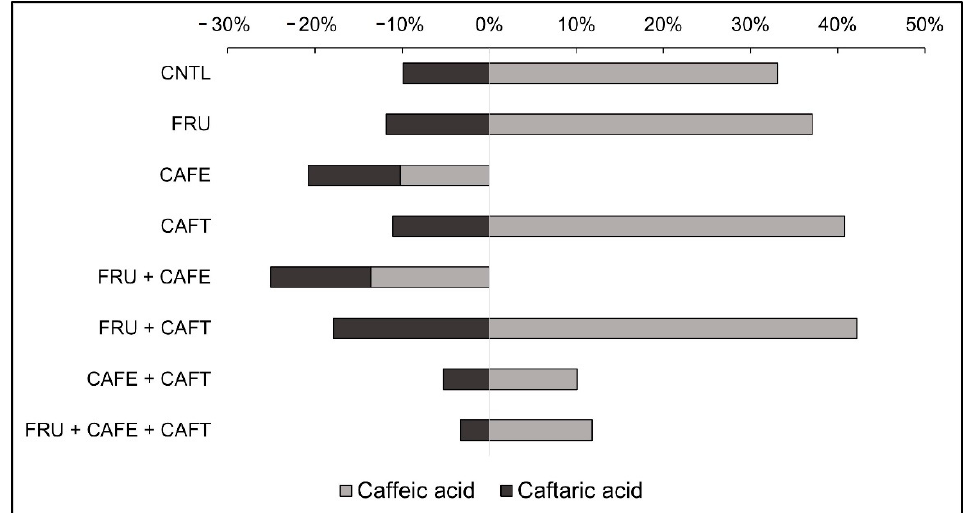
Figure 1. Percent difference in caffeic and caftaric acid concentrations between 30 ◦ C and 15 ◦ C temperature conditions after 90-days of storage. Percentage difference calculated as follows: |A − B|/[(A + B)/2] × 100%, where A is the compound concentration determined for the 30 ◦ C sample, and B is the concentration determined for the 15 ◦ C sample. +X% is interpreted as a relatively greater concentration determined at 30 ◦ C compared to 15 ◦ C, while − X% is interpreted as a relatively lower concentration. Treatment codes: CNTL (no addition), FRU (6 g/L fructose), CAFE (5 mg/L caffeic acid), CAFT (5 mg/L caftaric acid), FRU + CAFE (6 g/L fructose + 5 mg/L caffeic acid), FRU + CAFT (6 g/L fructose + 5 mg/L caftaric acid), CAFE + CAFT (5 mg/L caffeic acid + 5 mg/L caftaric acid), and FRU + CAFE + CAFT (6 g/L fructose + 5 mg/L caffeic acid + 5 mg/L caftaric acid). Table 1. Caffeic and caftaric acid concentrations determined via Liquid Chromatography-UV Diode Caftaric acid concentrations were impacted by treatment and storage temperature Array Detection (LC-UV/DAD) after treatment additions to base wines at the start (Day 0) and end ( K (DF 15) = 56.5, p < 0.001). Concentrations of caftaric acid in those treatments without (Day 90) of the temperature-controlled storage period. 5 mg/L caftaric acid addition (CNTL, FRU, CAFE, and F + CAFE) were found to be at 20.8, 21.3, 20.7, and 20.3 mg/L respectively. Those treated with caftaric acid (CAFT, F + CAFT, CAFE + CAFT, and F + CAFE + CAFT) are reported at 25.9, 26.1, 27.5, and 27.8 mg/L respectively (Table 1). Between 0 and 90 days, a trend of increasing caftaric acid was found; the overall average concentration of caftaric acid in unmodified samples increased from 20.9 mg/L to 26.3 mg/L (Table 1). This trend was observed for caftaric acid-addition samples as well, with an initial average of 27.0 mg/L compared to the 90-day sample average of 33.4 mg/L. Results for total hydroxycinnamic acids (HCAs) and the estimated degree of browning can be found in Supplementary